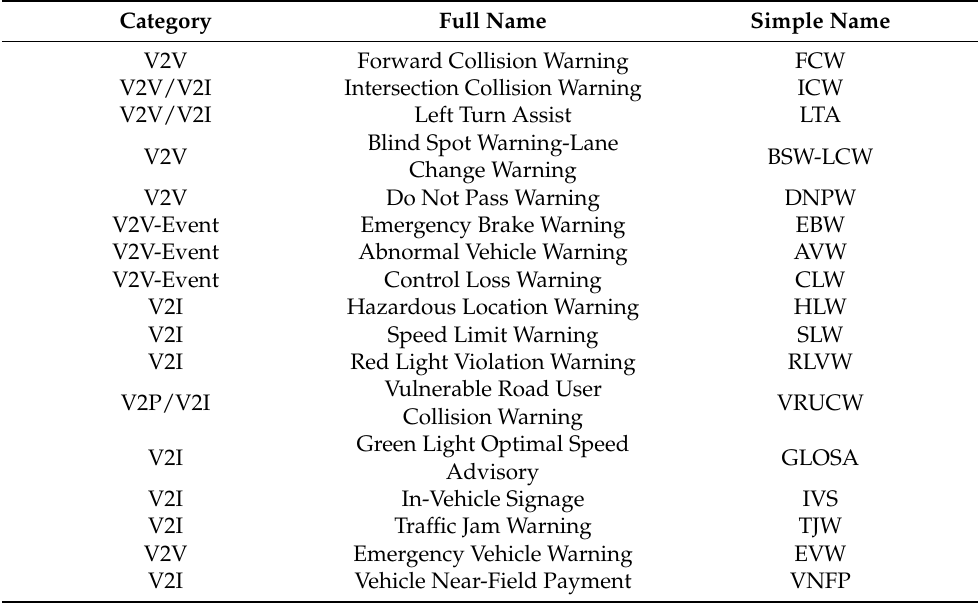
Table 2. V2X applications.